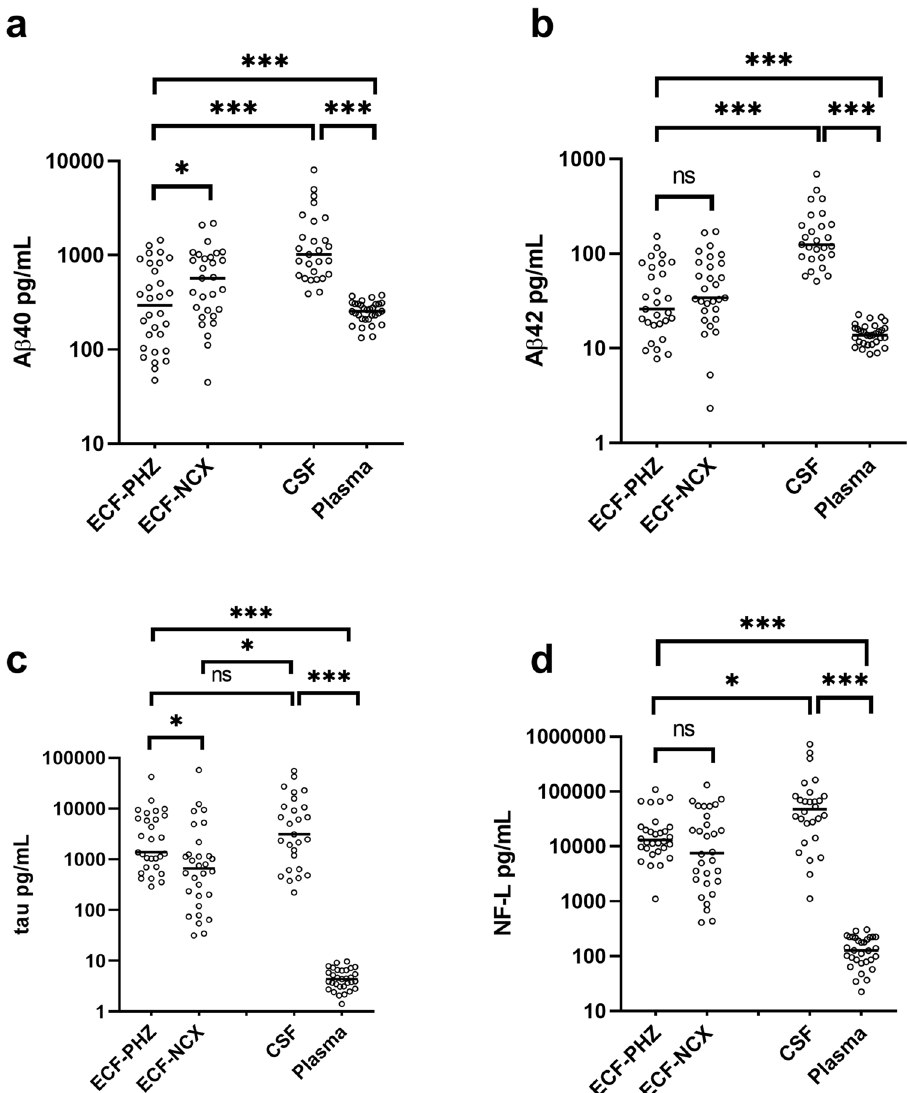
Figure 2. Aβ40 levels were lower, and tau levels higher, in perihemorrhagic zone (PHZ) when compared to non-injured cortex (NCX). All biomarker levels were lower in plasma, and higher in cerebrospinal fluid (CSF), compared to the extracellular fluid (ECF). ( a ) There were significantly lower levels of Aβ40 in extracellular fluid (ECF) of perihemorrhagic tissue (ECF-PHZ) compared to non-injured cortex (ECF-NCX; p = 0.048). Levels of Aβ40 were higher in CSF than ECF and plasma. ( b ) ECF levels of Aβ42 did not differ significantly between the PHZ and NCX. CSF levels of Aβ42 were higher than ECF and plasma levels. ( c ) ECF levels of tau were significantly higher in PHZ compared to NCX ( p = 0.031). CSF levels of tau were higher than ECF from NCX but not PHZ ( p = 0.209), and were higher than plasma levels of tau. ( d ) There was no significant difference in levels of Neurofilament light (NF-L) in ECF from PHZ compared to NCX. CSF levels of NF-L were significantly higher than in ECF and plasma. Aβ = amyloid-beta; Tau = microtubule-associated protein tau; NF-L = neurofilament light; ECF-PHZ = extracellular fluid of perihemorrhagic zone; ECF-NCX = extracellular fluid of non-injured cortex; CSF = cerebrospinal fluid; ECF = extracellular fluid; ns = not significant. * = p < 0.05; *** = p <